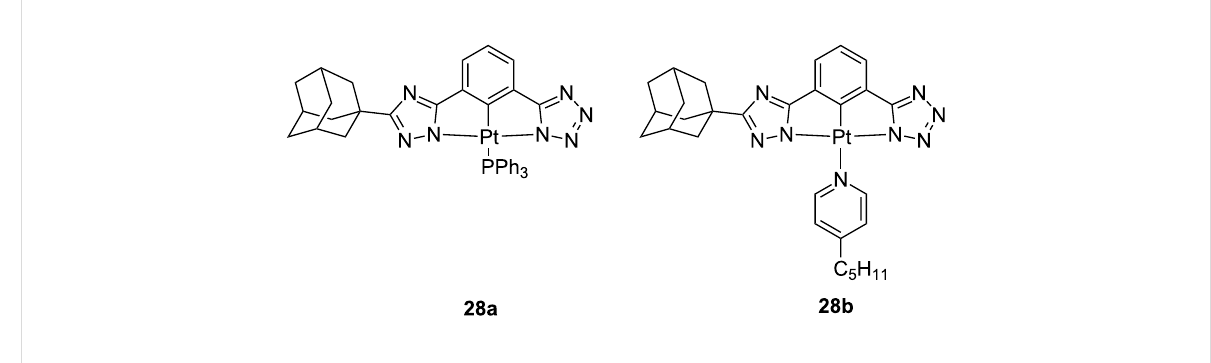
Figure 15: Chemical structure of the asymmetric Pt(II) derivatives 28 bearing triazole and tetrazole moieties onto a tridentate ligand [75].